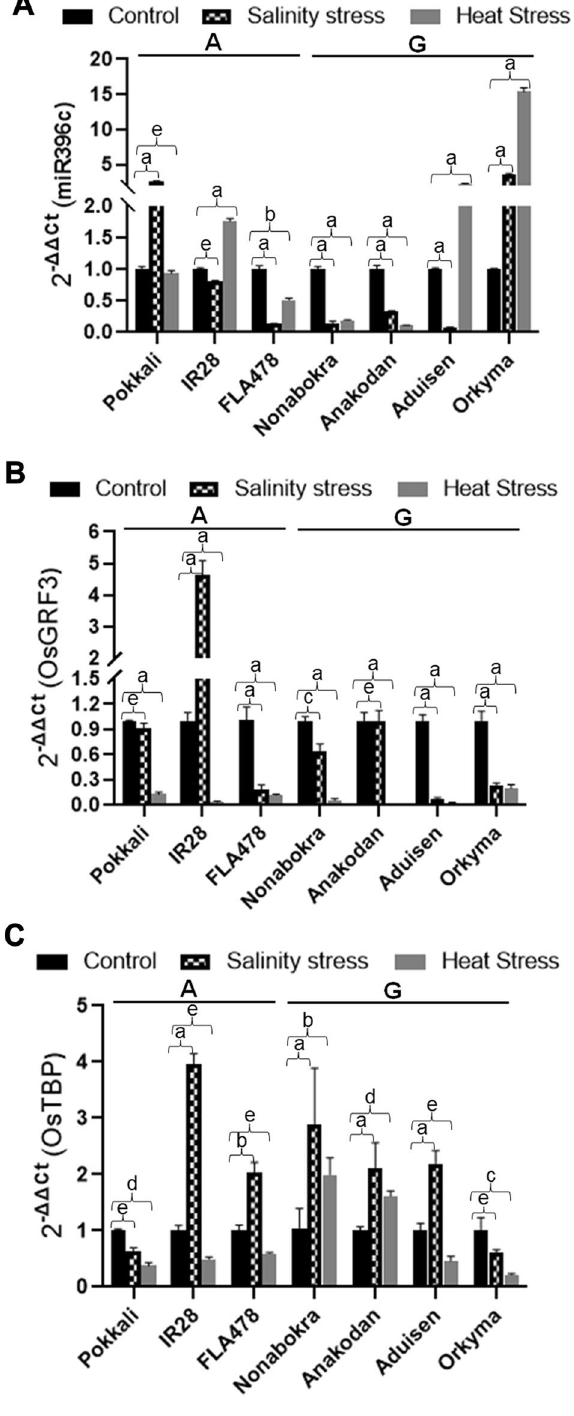
Figure 8. Expression analysis of ( A ) miR396c and target genes ( B ) OsGRF3 and ( C ) OsTBP under control, salinity and heat stress treatments in selected landraces/varietiesgrouped either ‘A’ or ‘G’. Pairwise statistical analysis of miR396c or OsGRF3 or OsTBP expression in landraces grouped either ‘A’ or ‘G’ ( A – C ) for each landrace/varieties (control vs. salinity or heat) using pairwise Student’s t-test (GraphPad V 6.0). Data is for three biological replicates per landrace/varieties per treatment (n = 3) with two/three technical internal replicates per treatment. a: P < 0.0001; b: P < 0.001; c: P < 0.01, d: P < 0.05; e: non